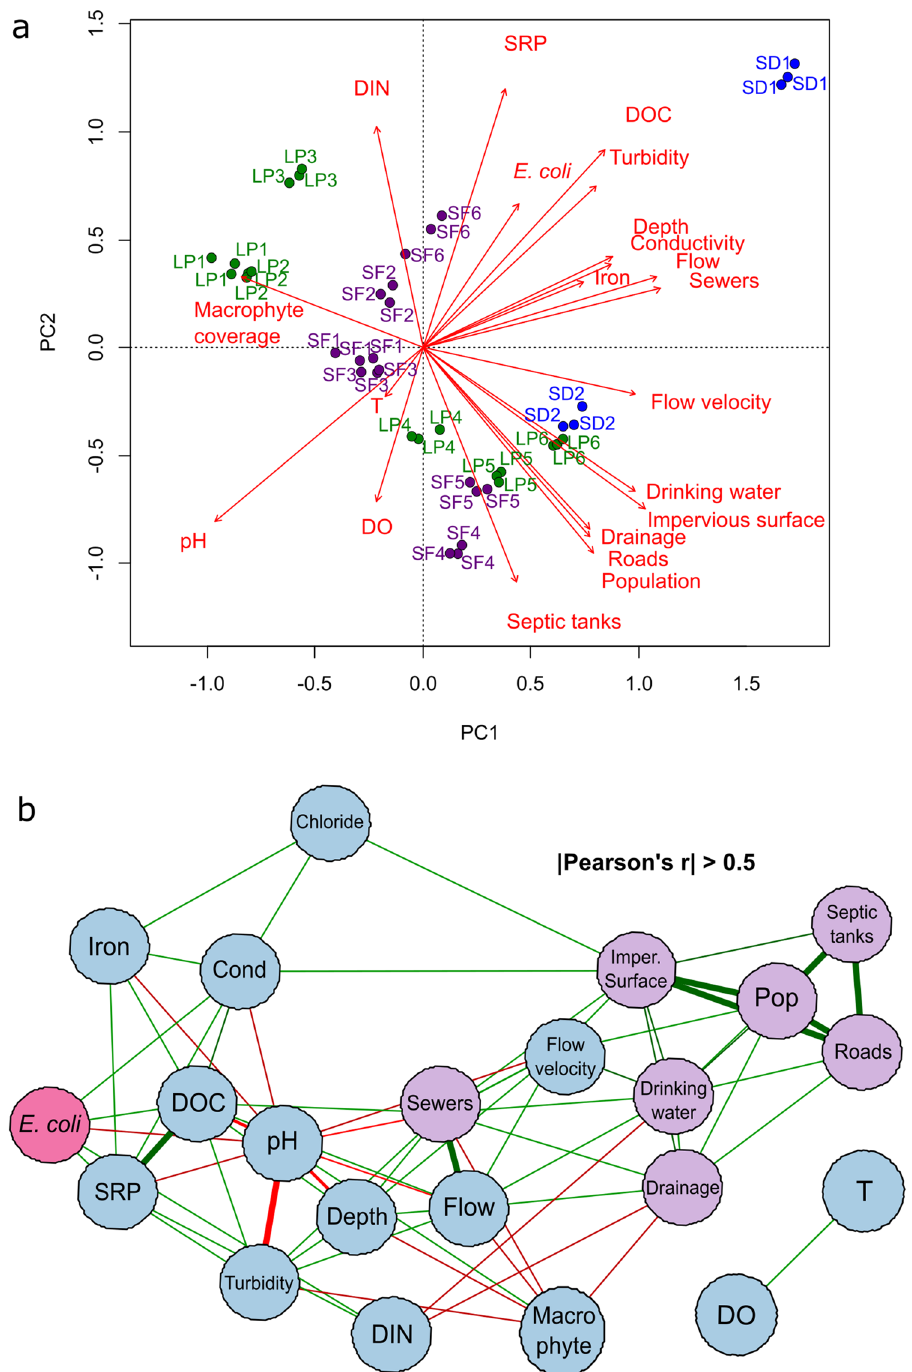
Figure 2. Relationship of E. coli abundance with environmental and urban infrastructure features ( a ) Biplot of a principal component analysis including all samples and variables. Sampled sites from San Francisco stream are in purple, Las Piedras stream in green and Santo Domingo stream in blue; ( b ) Network diagram of correlations with an absolute Pearson’s ρ greater than 0.5. Green edges correspond to positive correlations and red edges to negative ones; The edge width indicates the magnitude of Pearson’s ρ. Light-blue circles represent the environmental parameters, purple circles the infrastructure variables and pink circles the abundance of E. coli . LP, Las Piedras stream; SF, San Francisco stream; SD, Santo Domingo stream; DIN, dissolved inorganic nitrogen; SRP, soluble reactive phosphorus; DOC, dissolved organic carbon; DO, dissolved oxygen; T, temperature; Pop, population density; Cond, conductivity. Data analysis performed in R software 73 . Graphical edition in Inkscape V 0.92.4. Inkscape Project (2020). https:// inksc ape.